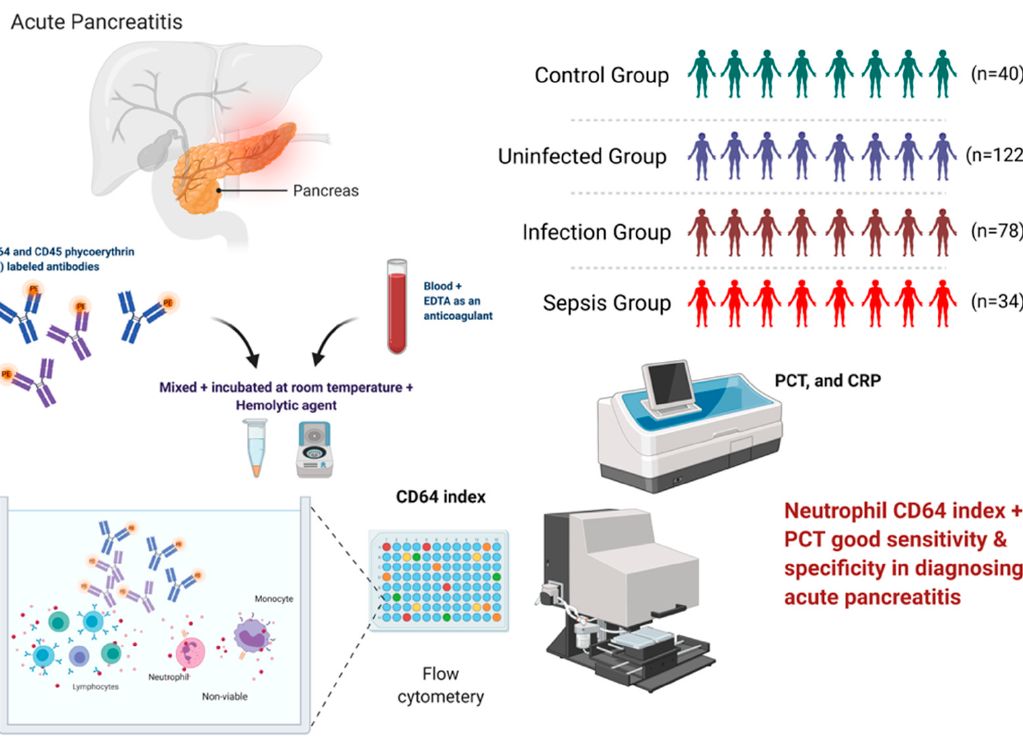
Scheme 1. Study Scheme 1. Study design.